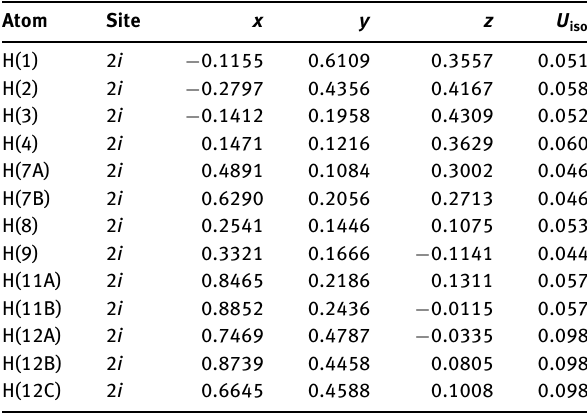
Table 2: Atomic coordinates and displacement parameters (in Å 2